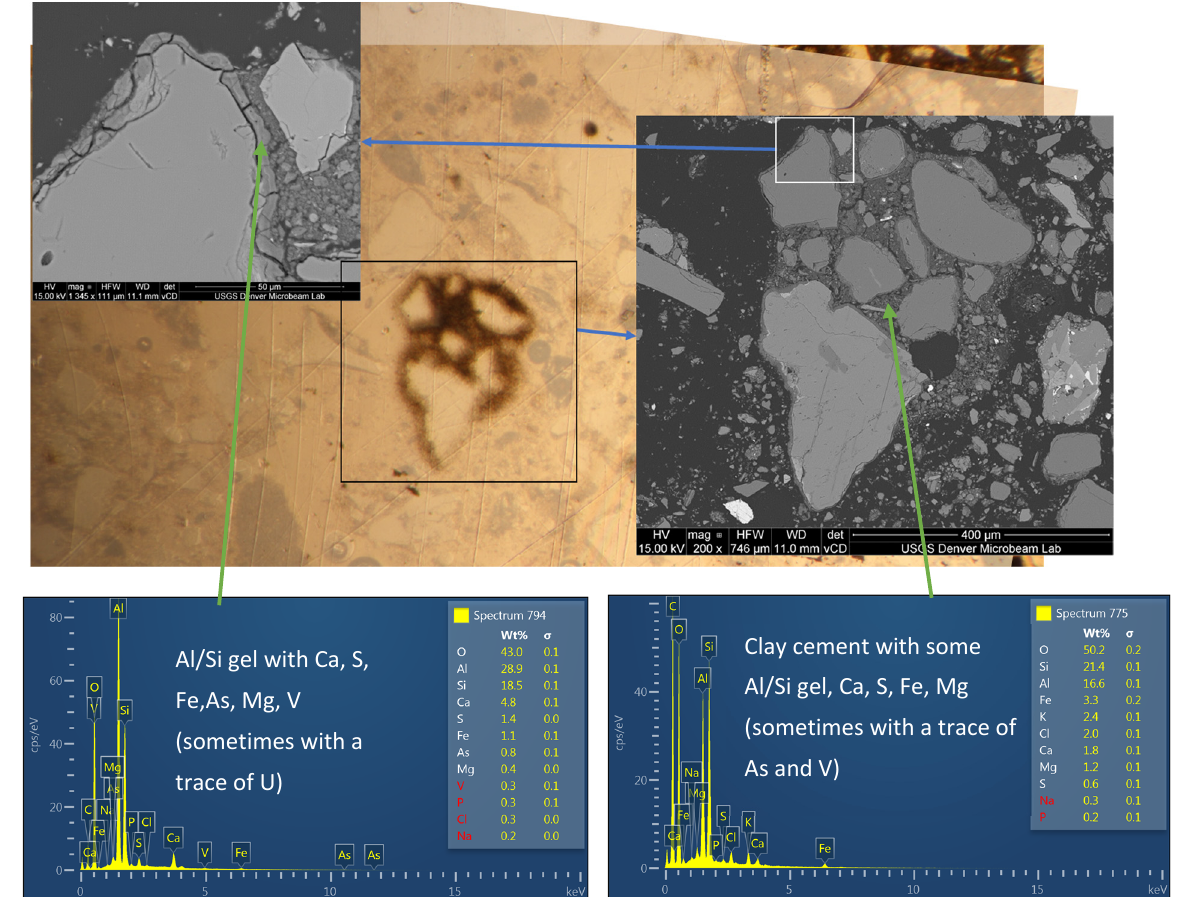
Figure 20. GJAST-20-10 duplicate area 1 (see S2), thin section plain light background with fission-track overlay at 25% transparency with SEM-BSE images.